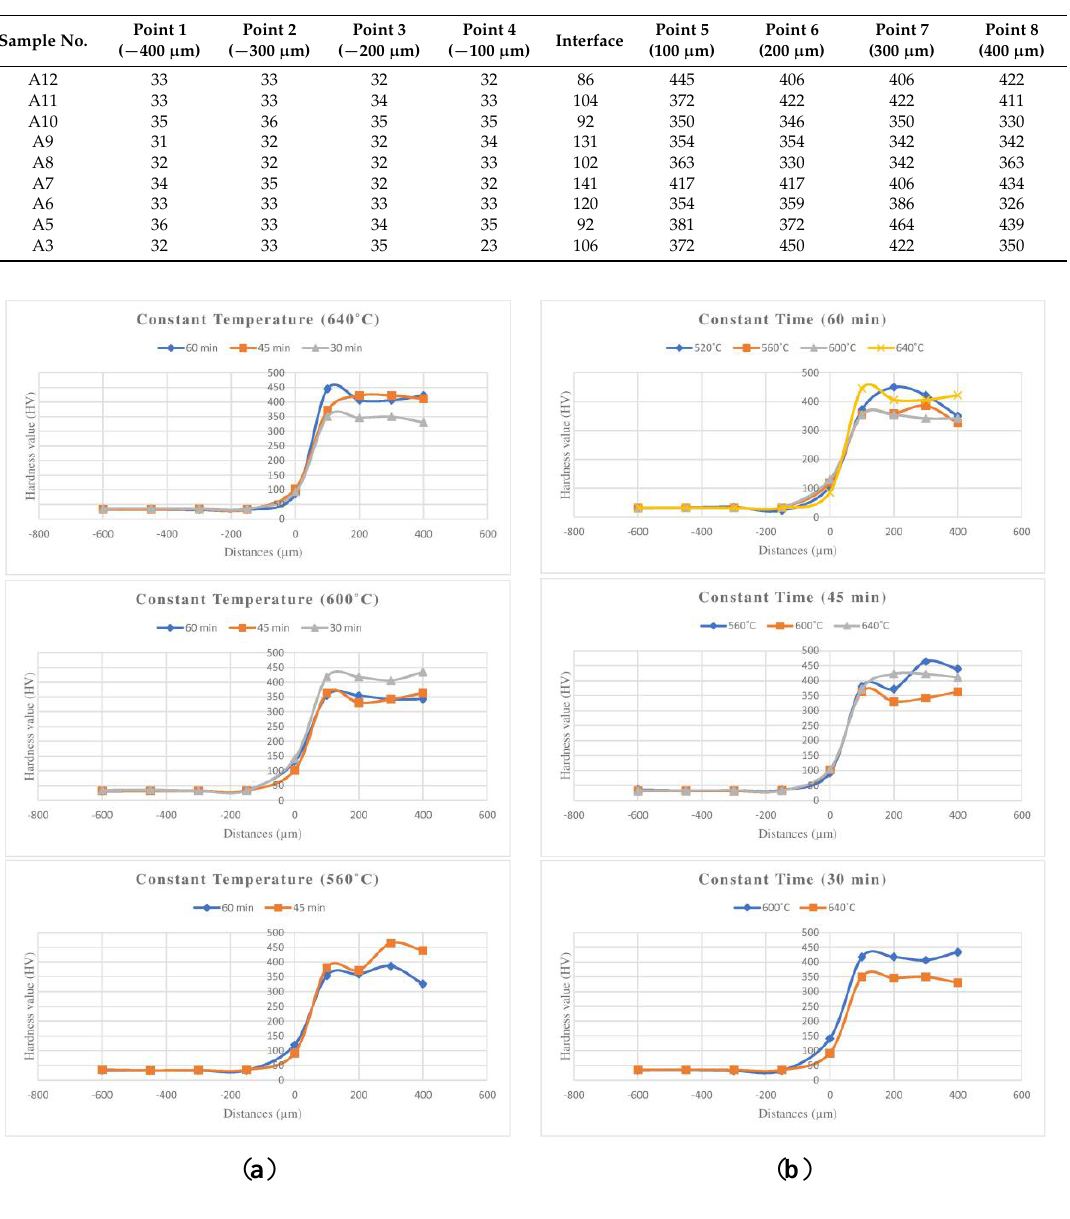
Figure 4. Hardness profiles of samples bonded based on ( a ) temperature and ( b ) time.